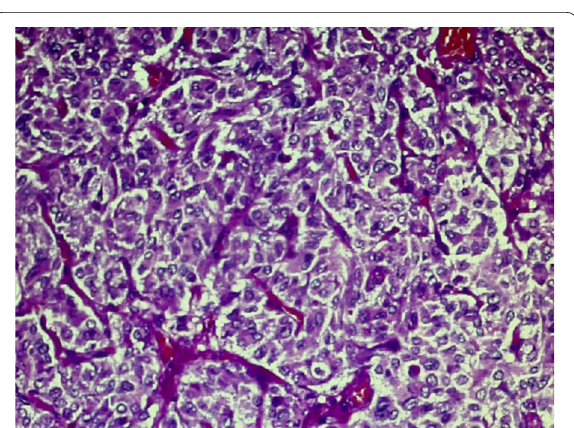
Fig. 4 pathology consistent with pheochromocytoma; sheets of cells with uniform